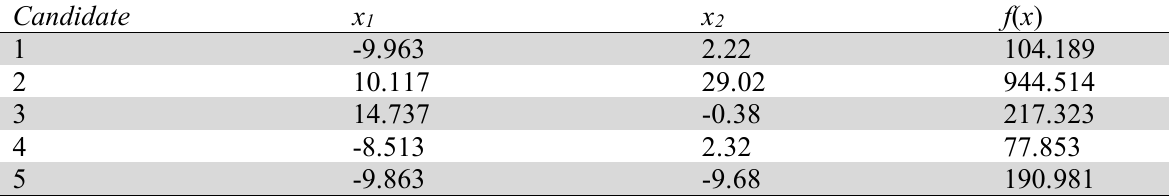
New values of the variables and the objective function during second iteration (Rao-3) Candidate